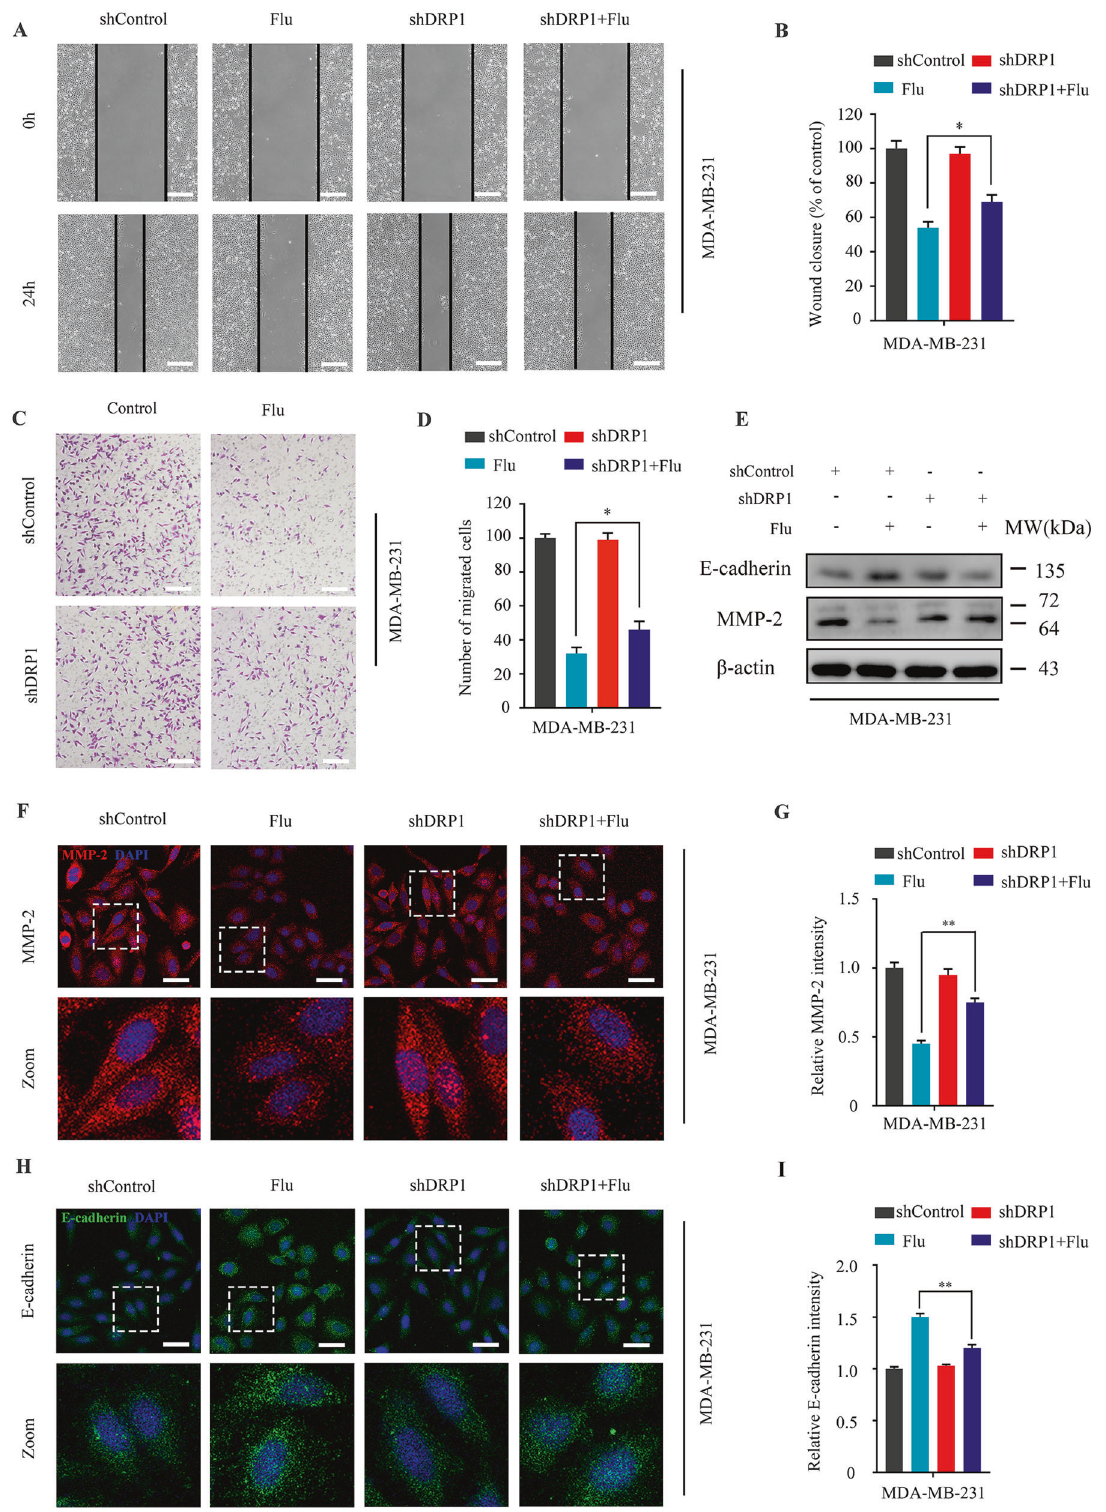
Fig. 5 Flubendazole-induced mitophagy enhances anti-migration potential in MDA-MB-231 cells. MDA-MB-231 cells were transfected with negative-control or DRP1 shRNA for 24 h and treatment with or without fl ubendazole (0.5 μ M) for 24 h. A , B The scratch assay was used to measure the migration capabilities of the cells. Representative images and statistics were shown. Scale bar, 100 µm. C , D Transwell assay was used to measure the number of migrated cells. Representative images and statistics were shown Scale bar, 50 µm. E Immunoblotting of E-cadherin and MMP-2 expression. β -actin was measured as the loading control. F – I The expression of MMP-2 and E-cadherin were analyzed by immuno fl uorescence. Scale bar, 20 µm. Data represent mean ± SD. * P < 0.05, ** P < 0.01, *** P < 0.001. Statistical signi fi cance compared with respective control groups (all P -values were obtained by one-way